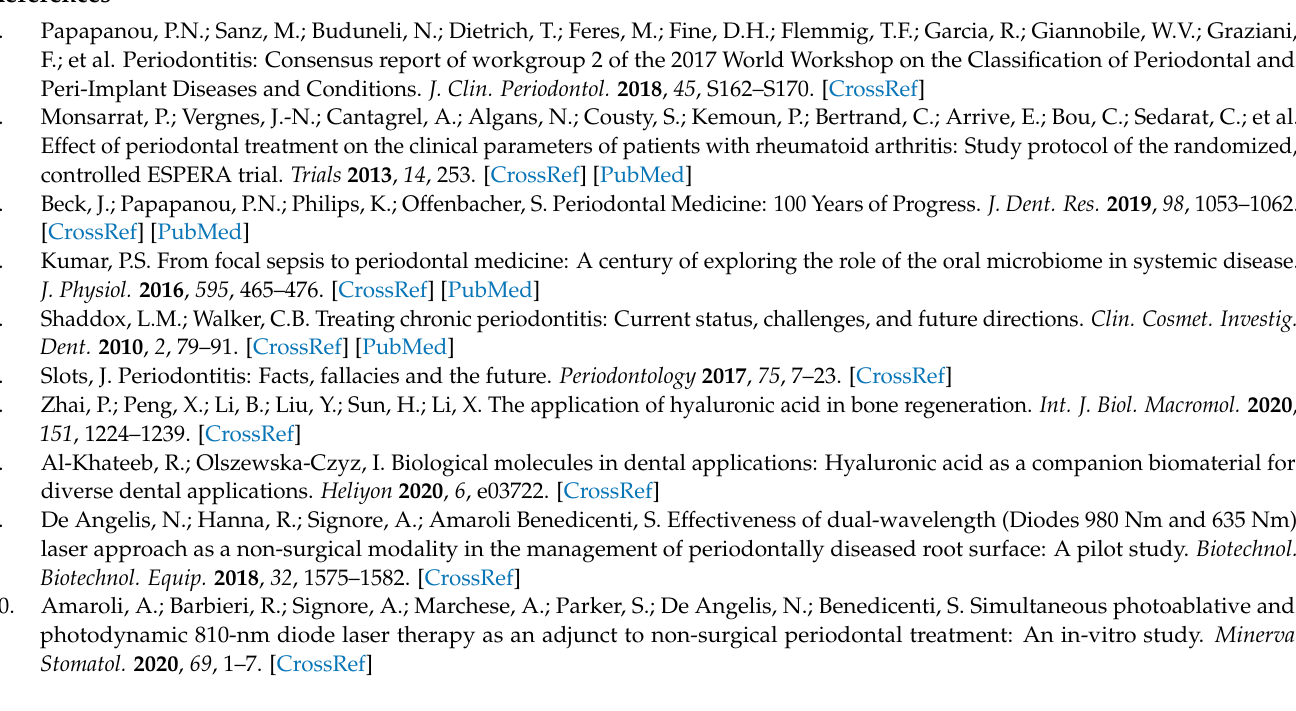
Figure A3. PPD values before ( left ) and after ( right ) treatment in the groups.